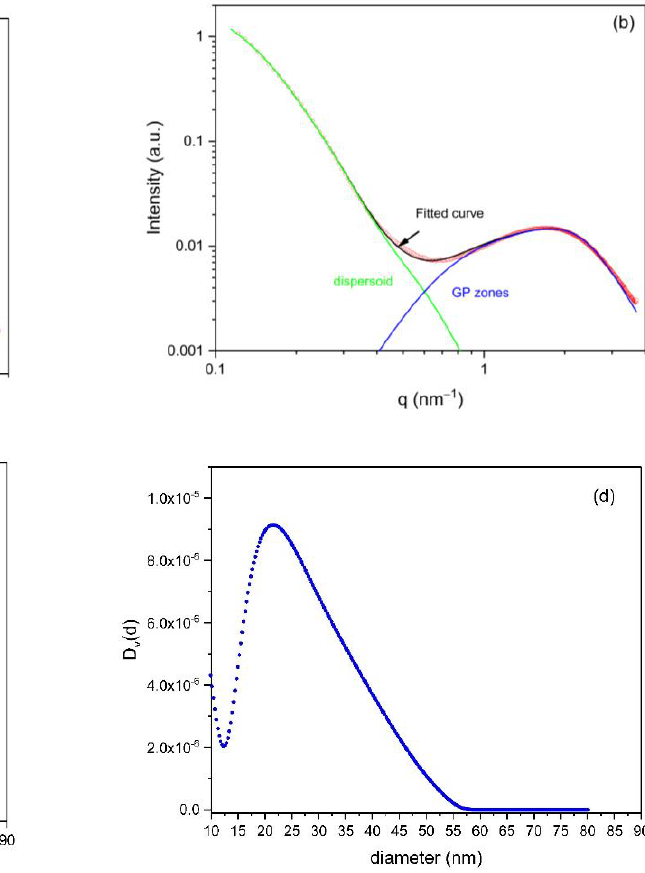
Figure 3. Fitted SAS curves from sample #13 with the contribution of different precipitate phases to the curve for SANS ( a ) and SAXS ( b ). Corresponding dispersoid-size distributions are shown for SANS ( c ) and SAXS ( d ), with D(d) being proportional to the volume.